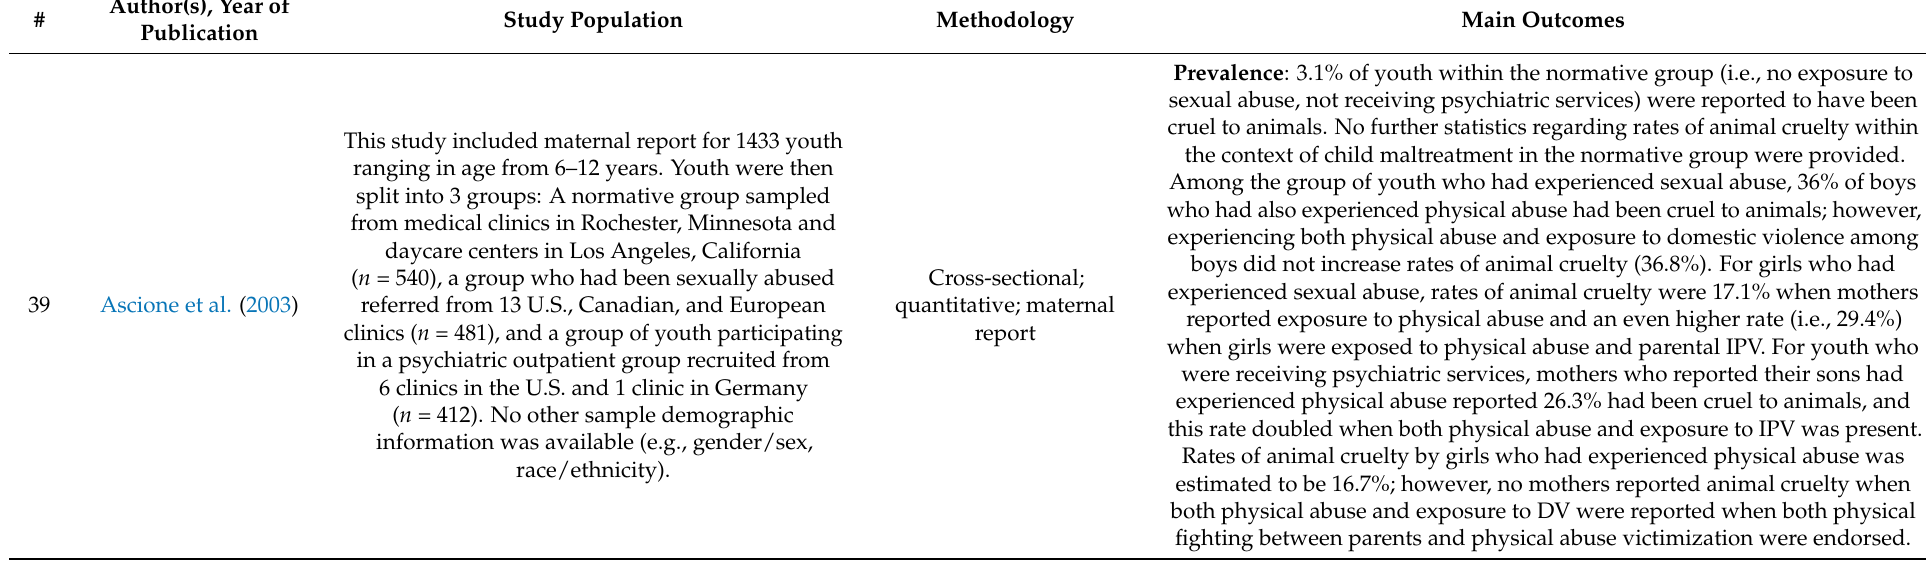
Table 6. Studies Included in the Scoping Review Examining Child Maltreatment and Youth Engagement in Animal